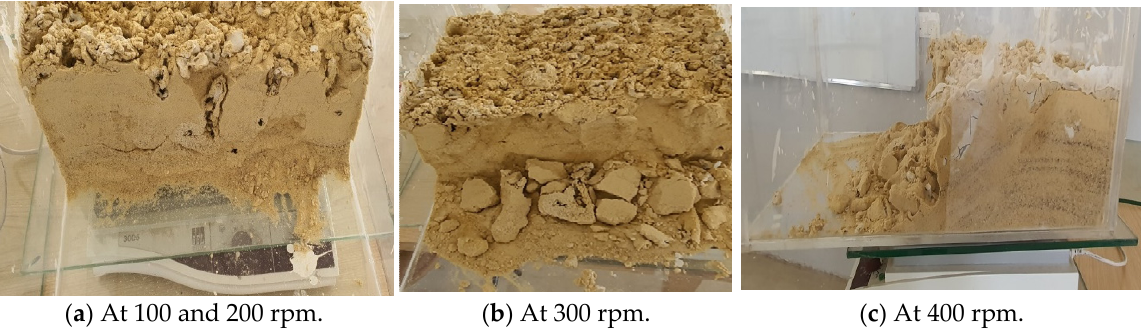
Figure 13. Shaking the stabilized sand with 3% bentonite clay at 100 to 400 rpm for 10 min each stage.